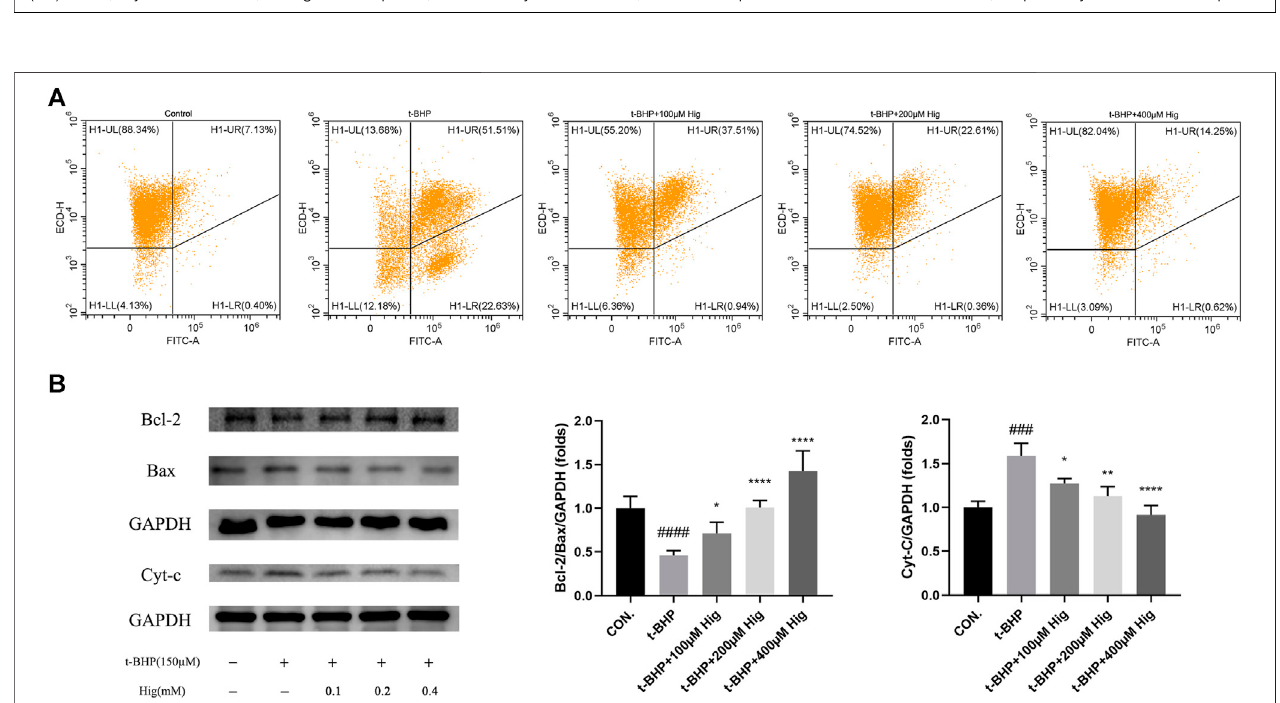
FIGURE 7 | Hig protected RSC96 against oxidative stress-induced apoptosis by regulating mitochondrial pathway. (A) △ Ψ m was detected by JC-1 probe using fl ow cytometer. The sum of quadrants H1-LL and H1-LR represented the depolarization extent of △ Ψ m. (B) Protein bands were detected by WB analysis. The ratios of Bcl-2/Bax protein level and the expression level of cyt-c protein were quanti fi ed. GAPDH served as an internal control. The results are presented as mean ± SEM, n (cid:2) 3. ### p < 0.001 and #### p < 0.0001 vs. the control group. * p < 0.05, ** p < 0.01, and **** p < 0.0001 vs. the t-BHP group.